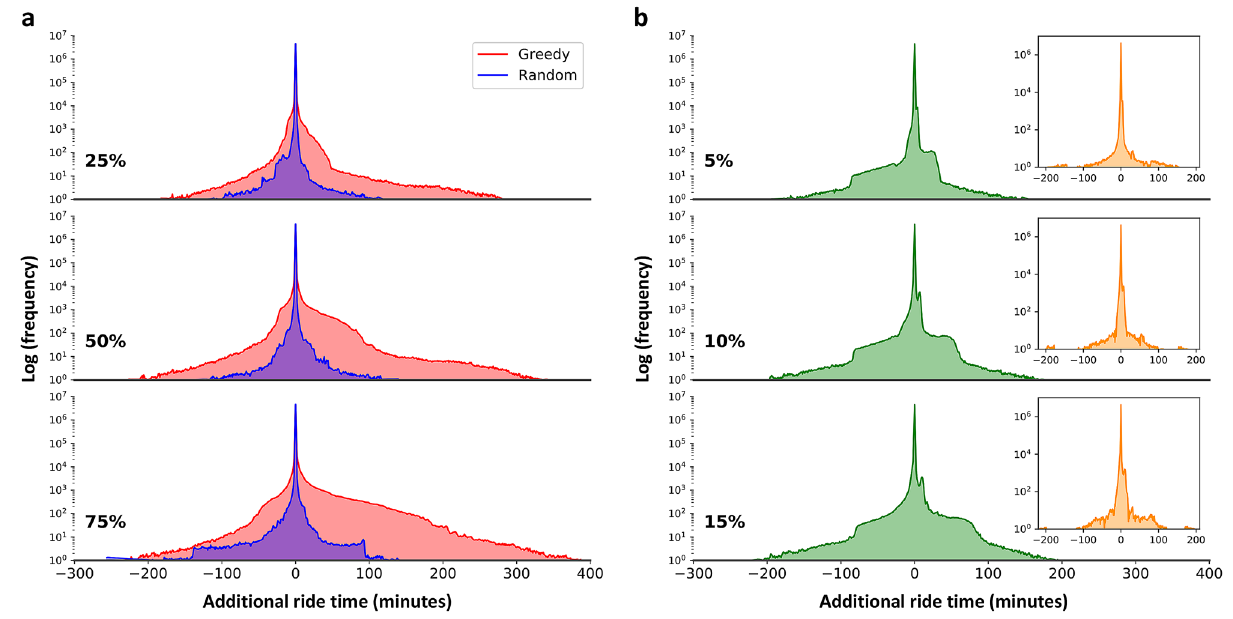
Figure 3. Impact on rides across the city. ( a ) Given varying disinformation follow-through rates (indicated in bold), the distribution of the additional ride time experienced by drivers after a divergence attack on 10 targets across the city, chosen either by our greedy heuristic or at random. ( b ) The same as ( a ) but for convergence attacks. The inset depicts the same distribution but instead of considering all rides, it considers only those that do not pass within 1 km of the target location. All results are shown as an average over 100